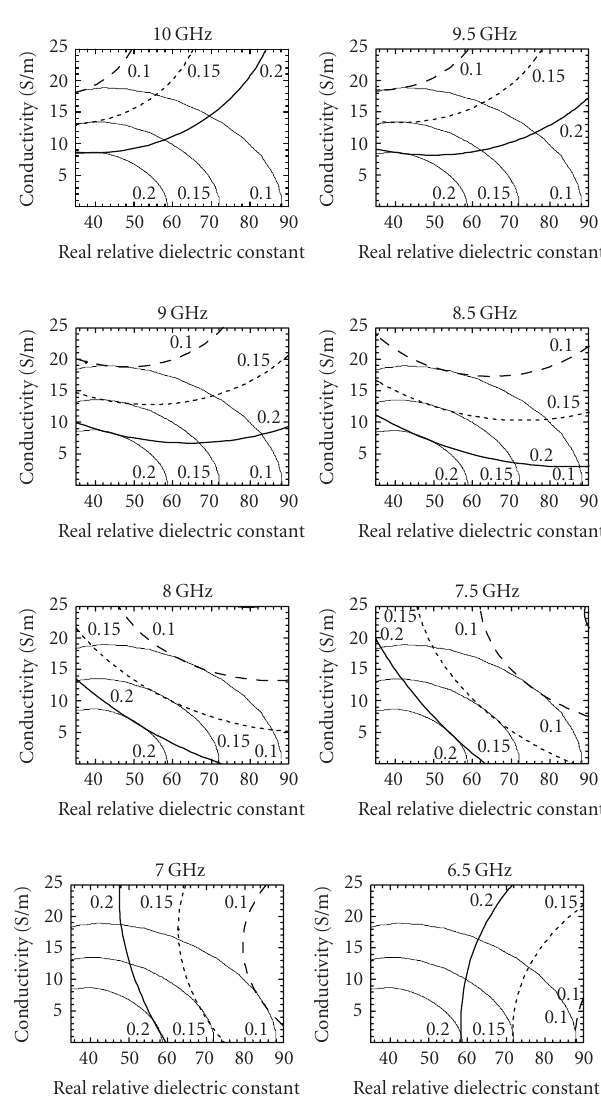
Figure 3: Contours of constant reflection magnitude | Γ | = 0 . 1 (dashed curves), 0.15 (dotted curves), and 0.2 (solid curves) as in- dicated, for frequencies: 10.0, 9.5, 9.0, 8.5, 8.0, 7.5, 7.0, and 6.5 GHz, as well as the common asymptotes for | Γ | = 0 . 1, 0.15, and 0.2, for practical values of bolus complex permittivity. The curve contours are extended from the centers shown in Figure